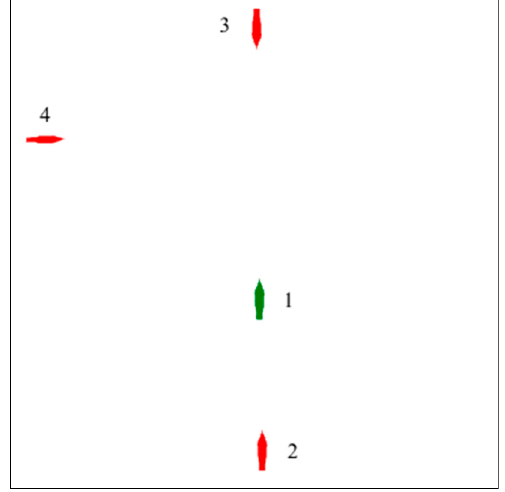
Figure 3. Initial positions of ships in the scenarios.